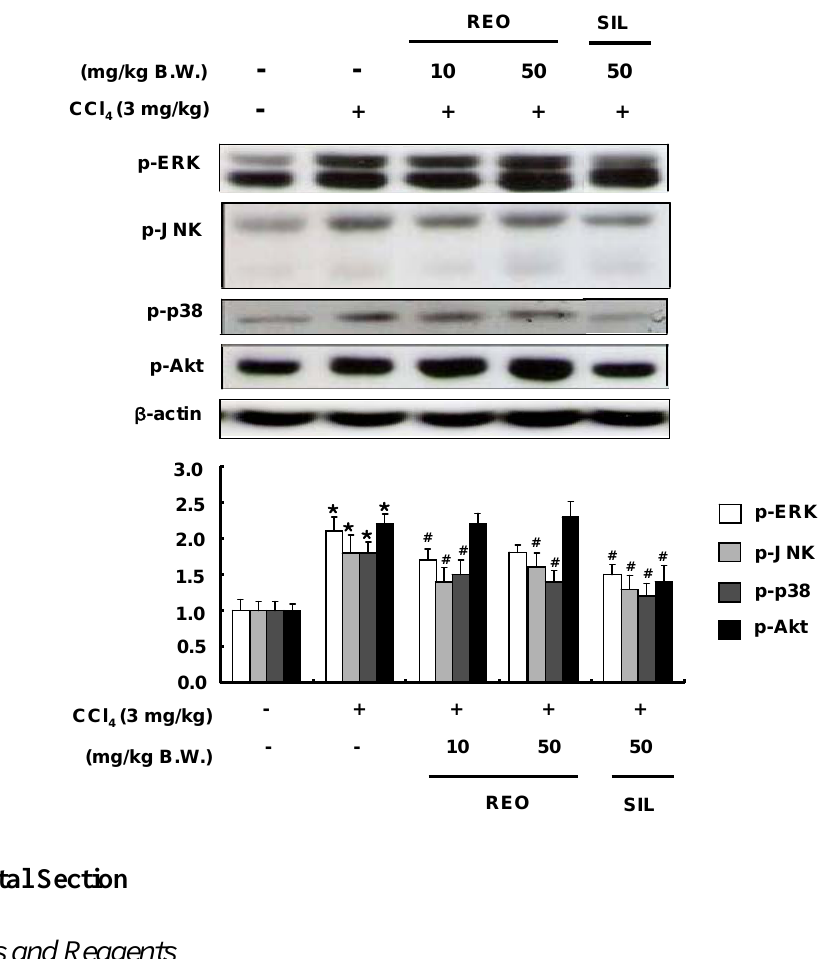
Figure 8. Effects of REO on MAP kinase and Akt protein expressions in liver of CCl -treated mice. Each value represents the mean ± SD for 8 mice. * p < 0.05, significant 4 differences from the unstimulated control group. # p < 0.05, significant differences from the CCl -treated 4